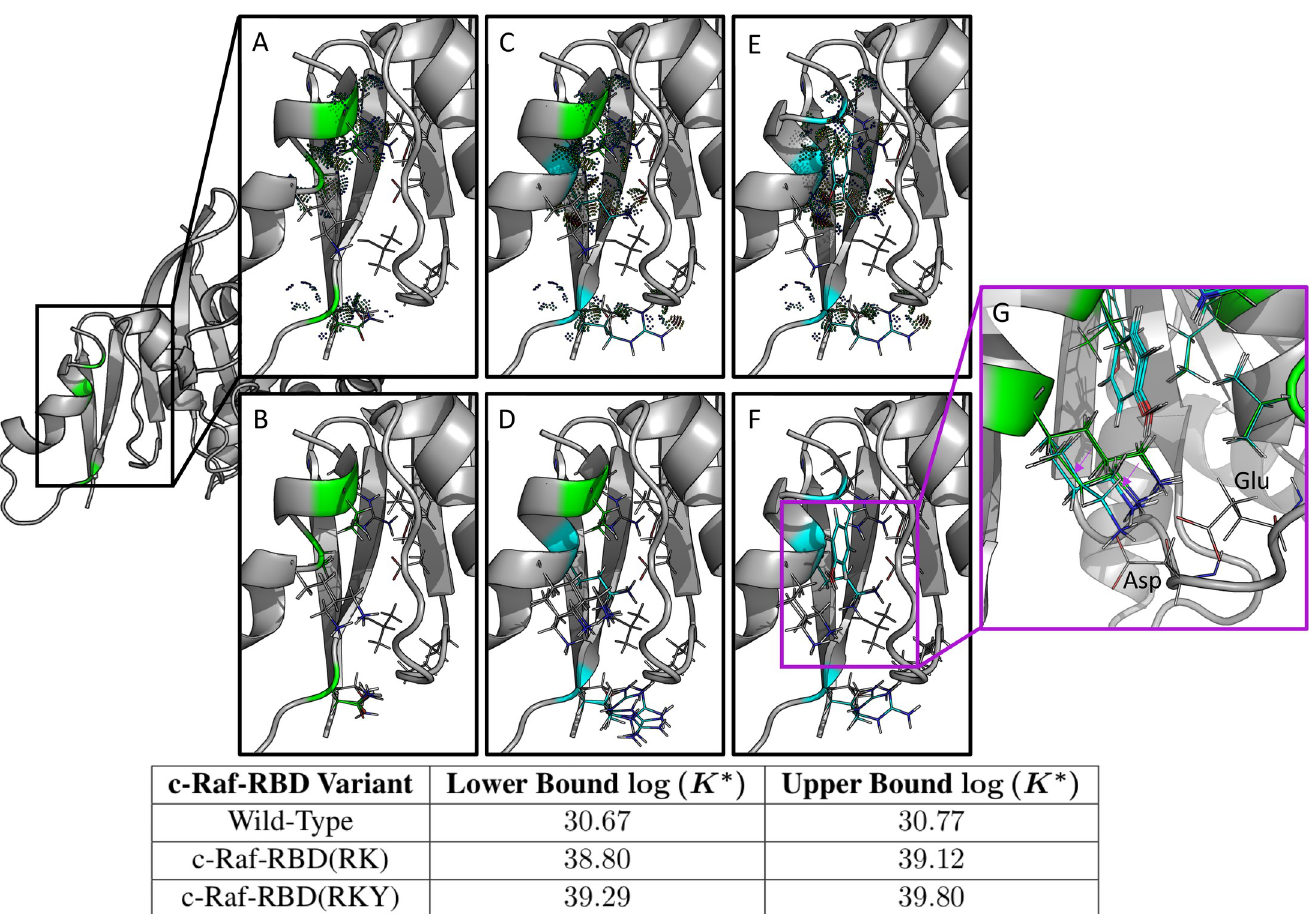
Fig 9. Computational predictions in the protein-protein interface of the c-Raf-RBD:KRas complex for c-Raf-RBD(RK) and the novel variant c-Raf-RBD(RKY). Shown on the left is only the relevant protein-protein interface between c-Raf-RBD and KRas. Each panel zooms in on this interface and details a different c-Raf-RBD variant and its corresponding computational predictions. The upper and lower bounds on the log( K � ) score for each design variant (wild-type, c-Raf-RBD(RK), and c- Raf-RBD(RKY)) are given in the bottom table. These computational predictions correspond with and are supported by the experimental results presented in the Section entitled “Experimental validation of mutations in the c-Raf-RBD:KRas protein-protein interface.” Panels (A) and (B) show the wild-type sequence, panels (C) and (D) show the variant c-Raf-RBD(RK), and panels (E) and (F) show the novel computationally predicted variant c-Raf-RBD(RKY). Panels (A), (C), and (E) show the wild-type, c-Raf-RBD(RK), and c-Raf-RBD(RKY), respectively, along with probe dots [71] that represent the molecular interactions within each structure calculated by OSPREY . These probe dots were selected to only show interactions between the residues included in the computational designs (shown as green and blue lines) with their surrounding residues. Panels (B), (D), and (F) show 10 low-energy structures from each conformational ensemble calculated by OSPREY / EWAK � . Panel (G) shows a zoomed-in overlay of the wild-type variant with the c-Raf-RBD variant that includes only the V88Y mutation. Purple arrows indicate the change in positioning of the lysine at residue position 84 upon mutation of residue position 88 from valine to tyrosine. When valine is present at position 88, the lysine residue (shown in green) primarily hydrogen bonds with an aspartate (labeled) in KRas. When valine is mutated to tyrosine (shown in cyan), the lysine at position 84 moves to make room for the tyrosine and positions itself to hydrogen bond with both the aspartate and the glutamate (labeled) in